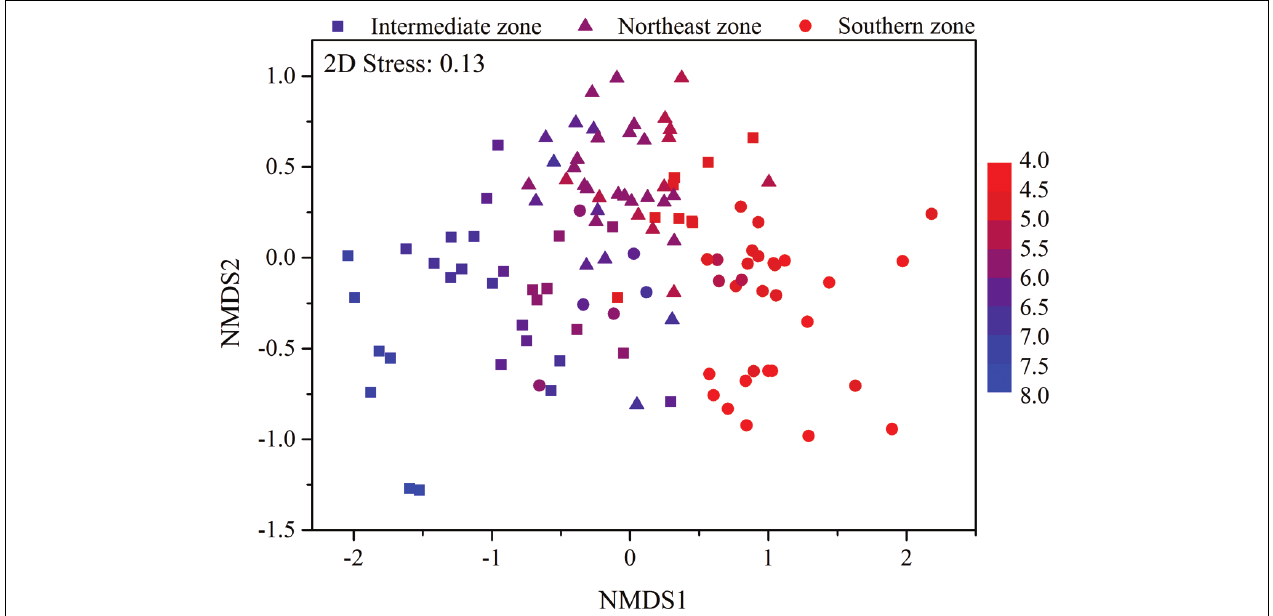
FIGURE 5 | Non-metric multidimensional scaling (NMDS) plot of bacterial community composition from 115 sites in typical Chinese forest soils. Sites are color coded according to the soil pH values. The filled circle represent sites in southern zone with latitude between 18.70 ◦ N and 29.65 ◦ N, the filled triangles represent sites in northeast zone with latitude between 40.51 ◦ N and 51.53 ◦ N and the filled squares represent sites in intermediate zone with latitude between 31.30 ◦ N and 39.96 ◦ N.